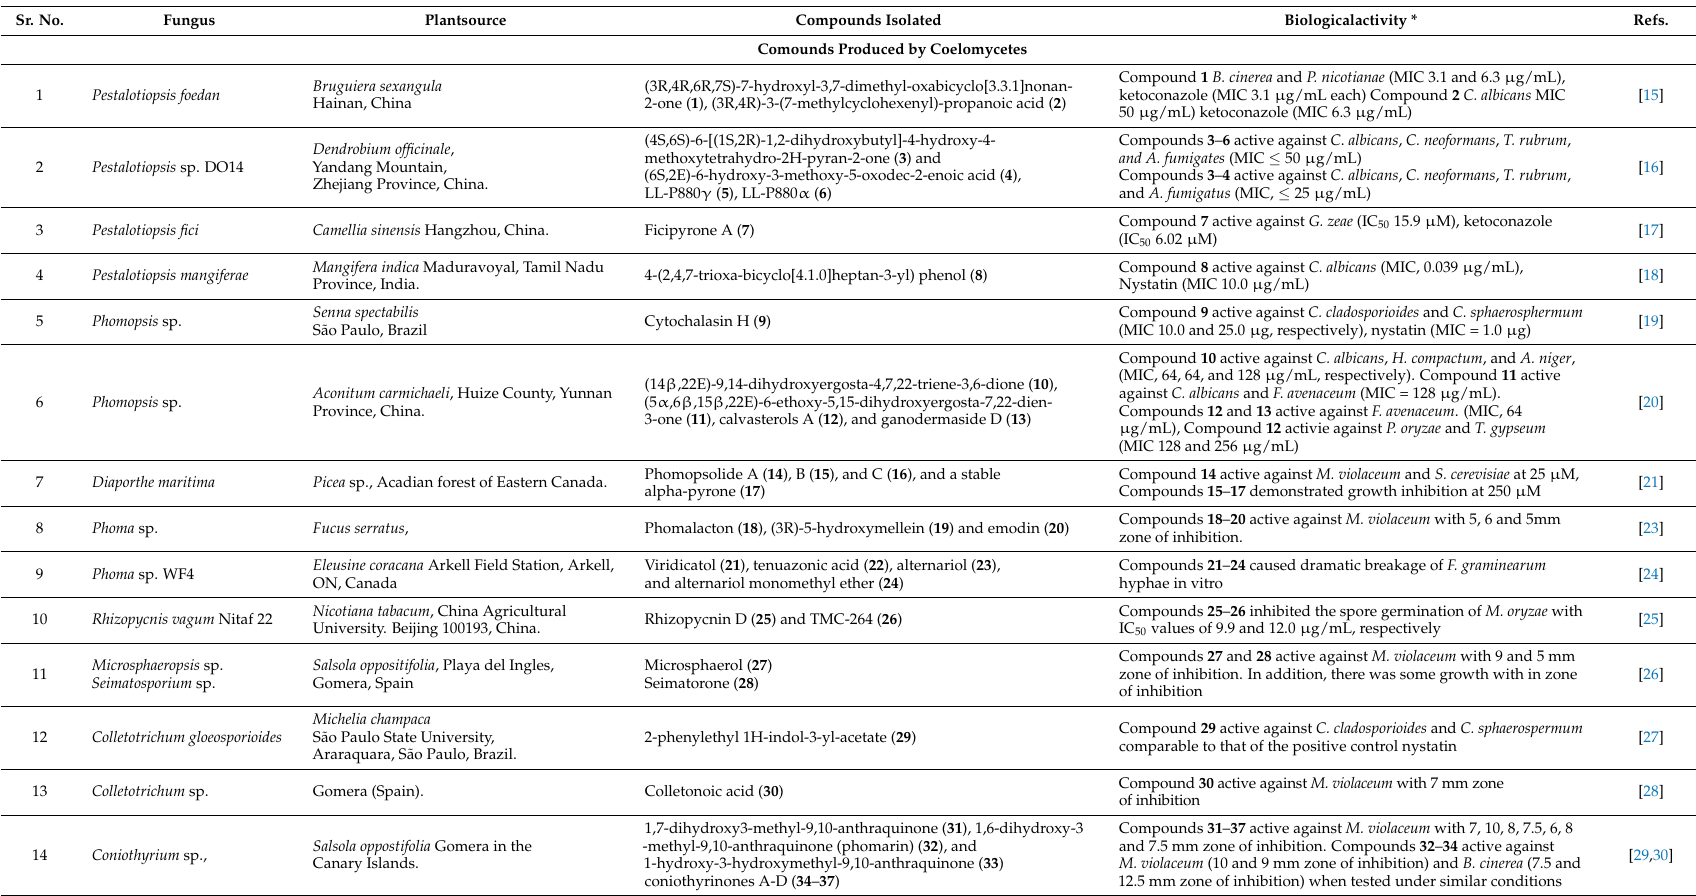
Table 1. Antifungal compounds reported from endophytic